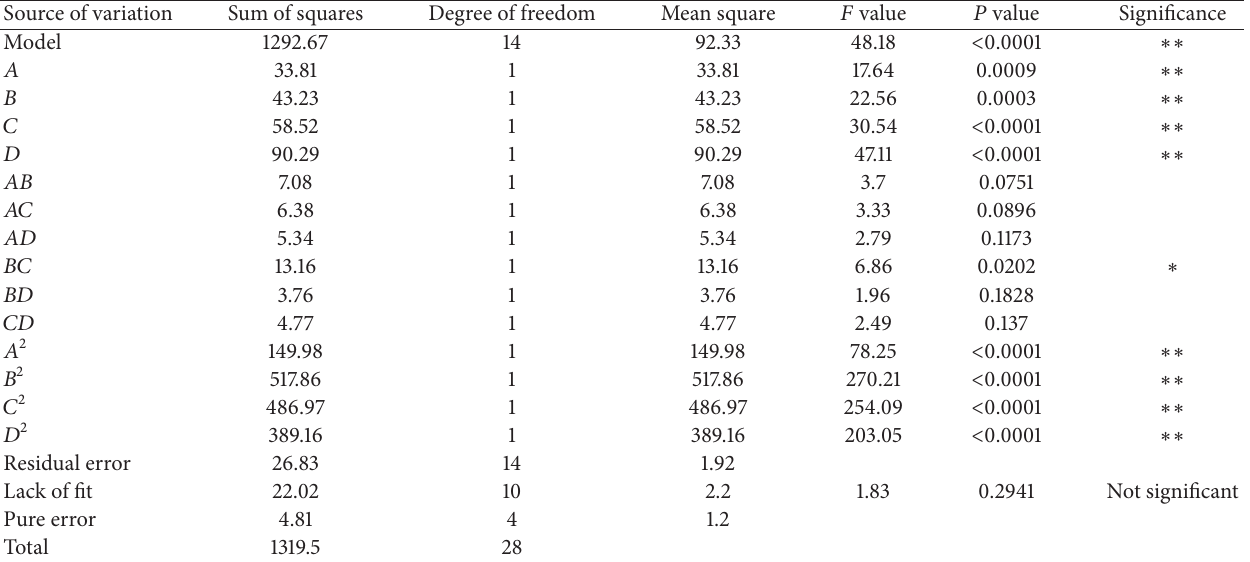
Table 3: The ANOVA of extraction rate of tea saponin extracted from oil-tea cake. Source of variation